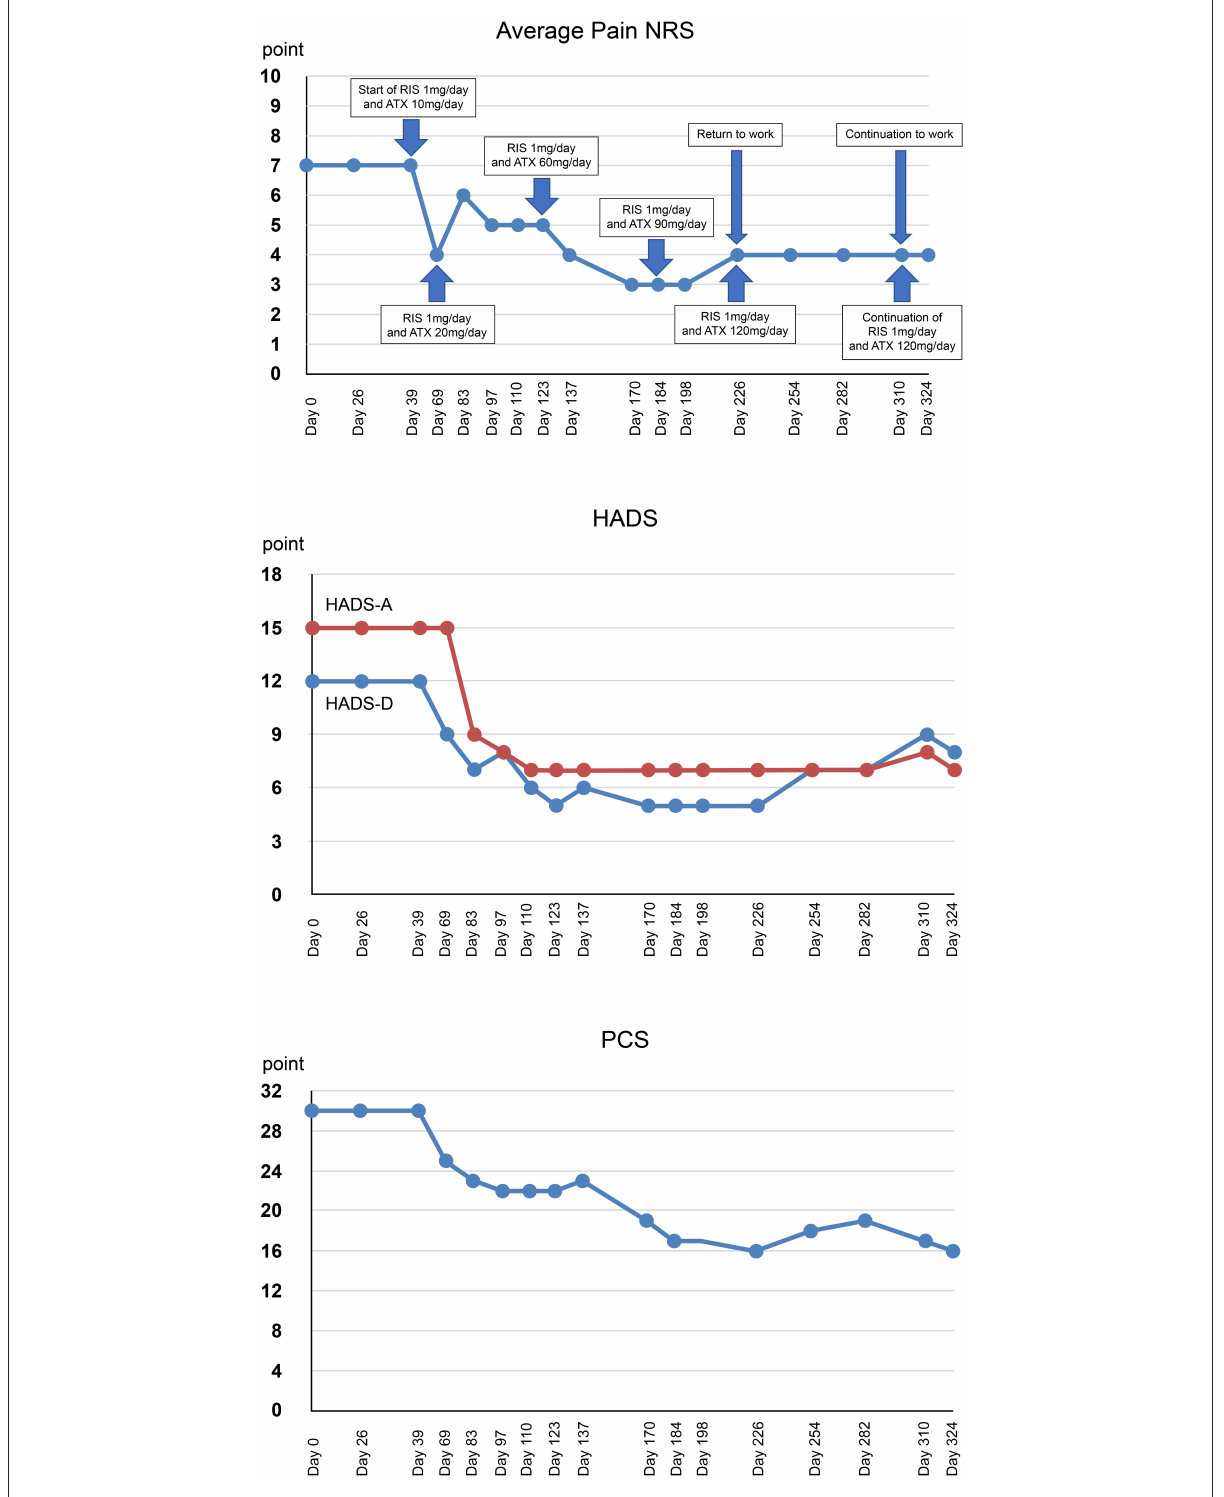
FIGURE2 Timeline of events and medication and changes in the rating scale over the course of treatment. RIS, risperidone; ATX, atomoxetine; NRS, numerical rating scales; HADS-A/D, hospital anxiety and depression scale-anxiety/depression; PCS, pain catastrophizing